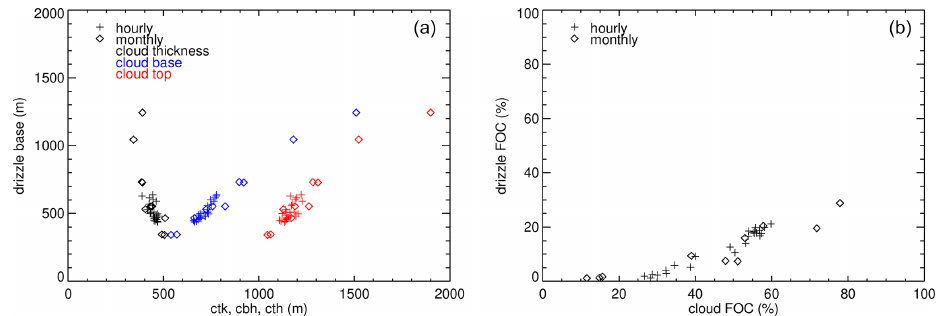
Figure 10. (a) Drizzle basis (height at which drizzle evaporates completely z de ) as a function of the cloud base (blue), cloud top (red), and cloud thickness (black). (b) FOC of drizzle at any height as a function of FOC for clouds. Monthly averages over all hours are denoted by a + symbol, and hourly averages over all months for different hours are indicated by a (cid:5) symbol.